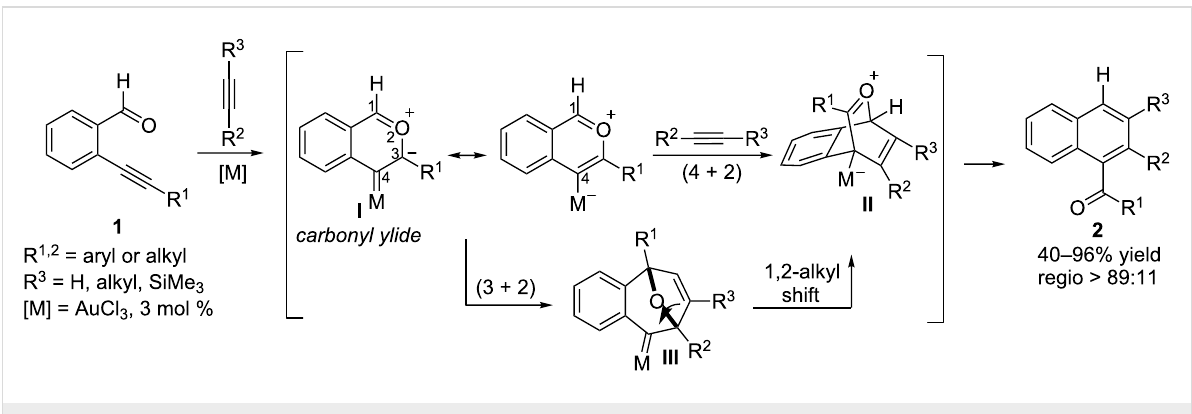
Scheme 1: AuCl 3 -catalyzed benzannulations reported by